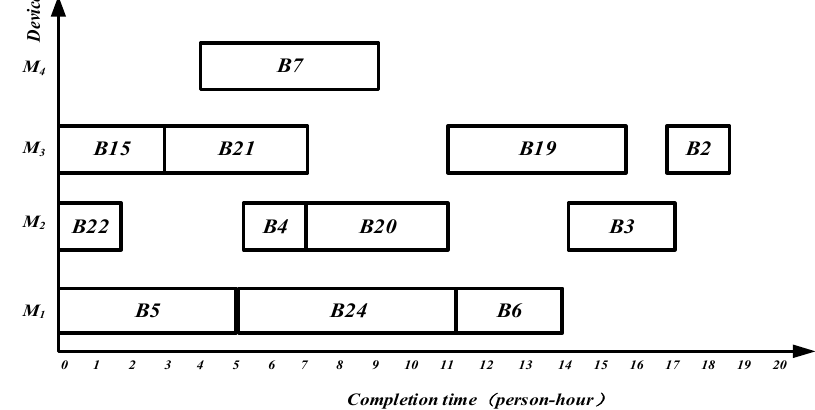
with 24 person ‐ hours. 1